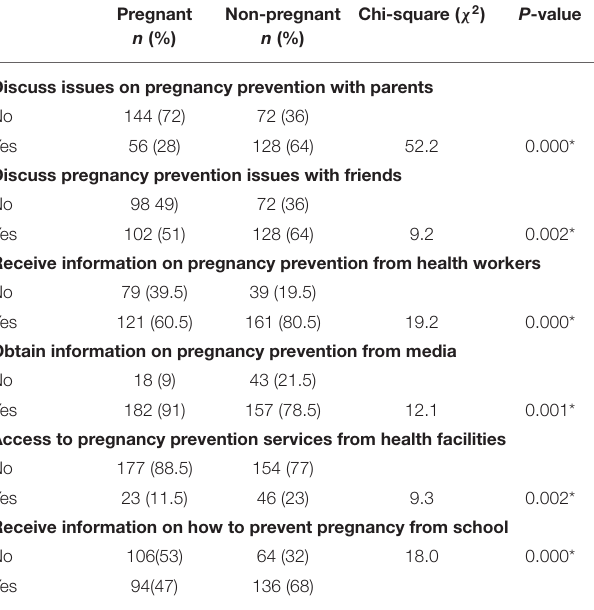
in Table 3 . Five independent variables (i.e., discussion